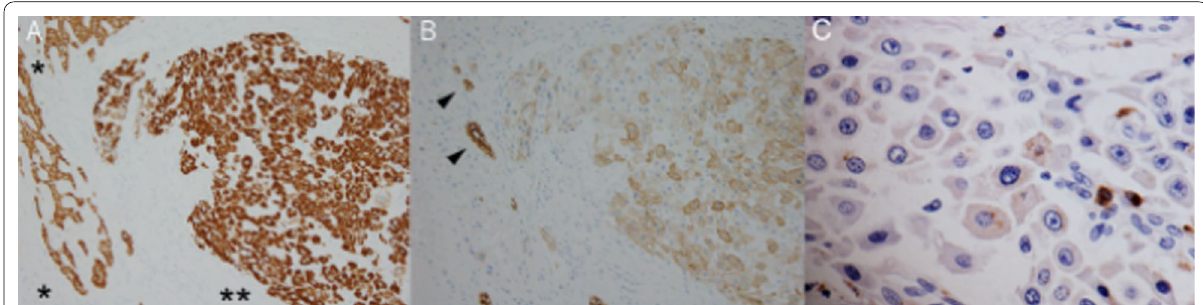
Fig. 3 Immunohistochemical findings of the tumor. Tumor cells showed diffuse, intense staining for Hep Par-1. Note that more intense staining for the tumor part (**) compared to the background hepatic parenchyma (*) ( A ). Tumor cells showed diffuse, weak staining for CK7. Arrowheads indicate bile ductules ( B ). Positive staining for CD68 was also noted, although it was only focal staining ( C )